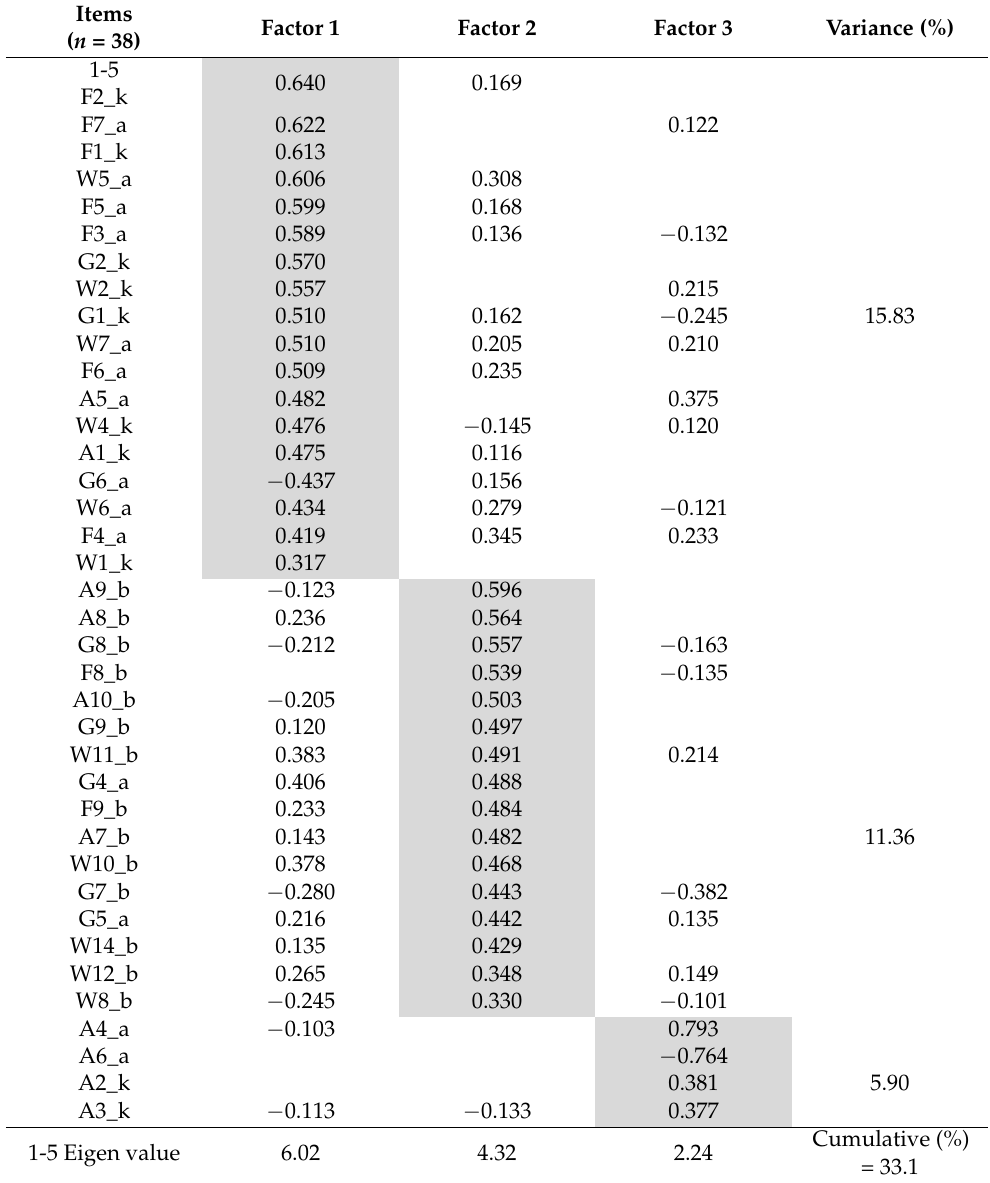
Table 2. Exploratory Factor Analysis of the Korean version of the Environmental Health Literacy (K-EHL) Scale ( n =